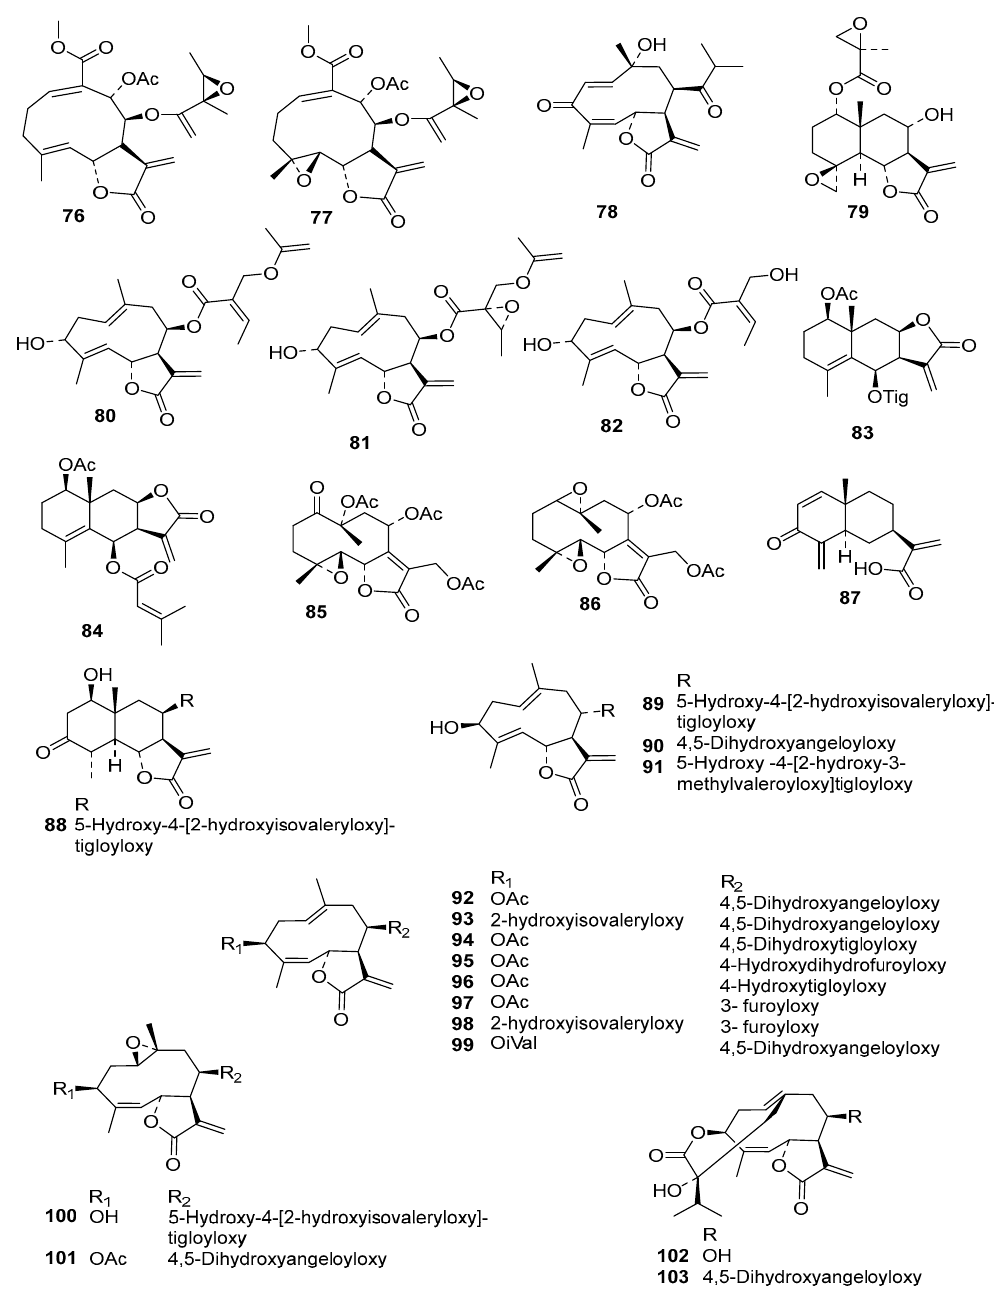
Figure 1. Cont. Structures of STLs used in the present QSAR analysis. Part 3 of the data set with Figure 1. Cont compounds newly included in this QSAR study. 76 – 78, 80 – 82, 85 – 86, 89 – 103 : germacranolides; 79, 83 – 84, 87 – 88 : eudesmanolides.